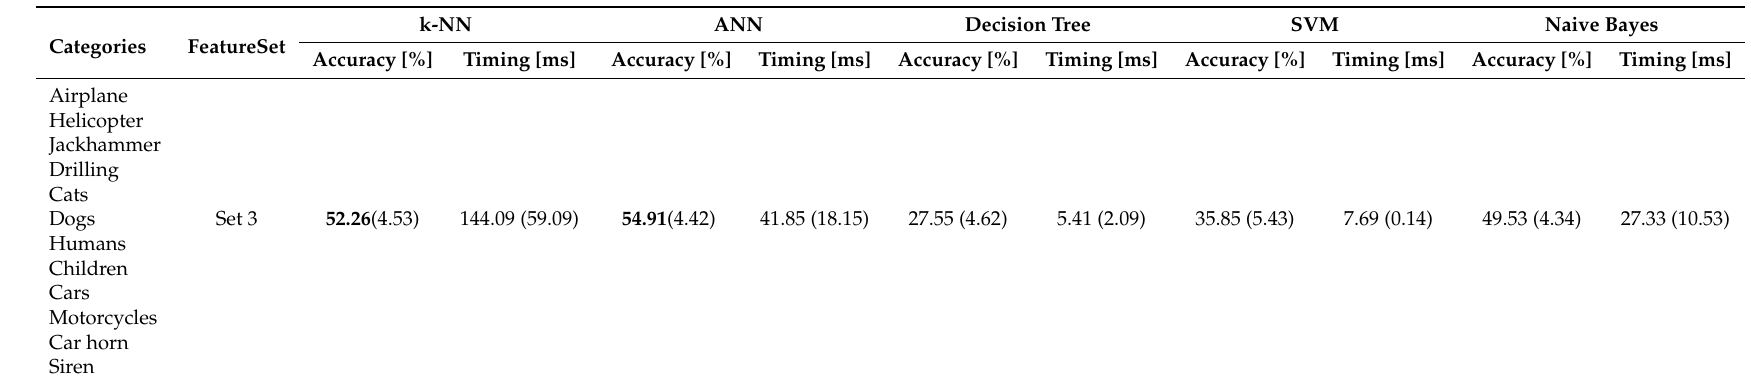
Table 17. Achievable accuracy and demanded execution time of the optimized classifiers performance using the non-cascade approach running on the Raspberry Pi. The Standard Deviation (SD) is in